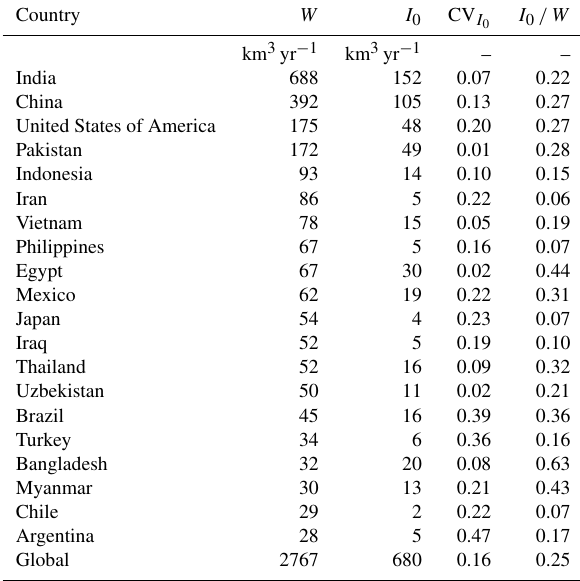
Table 1. Area-average discharge (mmyr − 1 ) for selected basins as observed and estimated by the model in the presence ( Q n ) and ab- sence ( Q g ) of secondary evaporation, respectively. Listed data for basins with discharge less than 300mmyr − 1 only (cf. Fig. 5c, d).